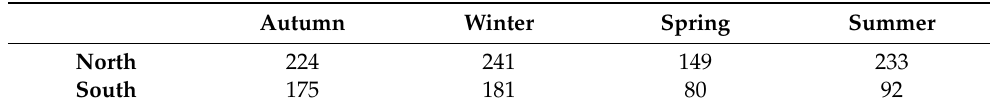
Table 1. The number of fish sampled per thermal zona (northern and southern coast) in each season (autumn, winter, spring and summer). Autumn Winter Spring Summer North 224 241 149 233 South 175 181 80